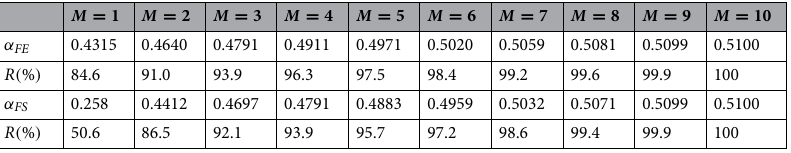
Table 7. Comparison of variance/STD scores for feature extraction and variance scores for feature